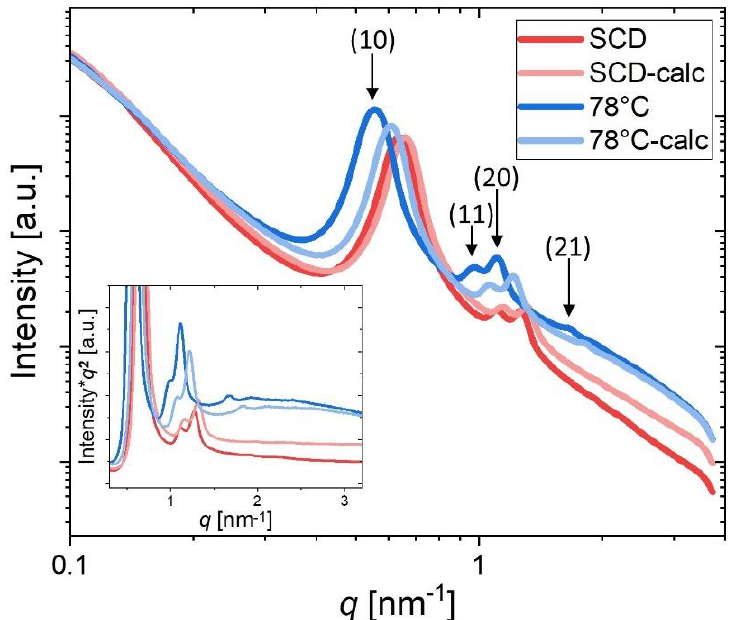
Figure 3. Selected nitrogen physisorption isotherms for the hierarchically organized silica materials after the respective drying process.